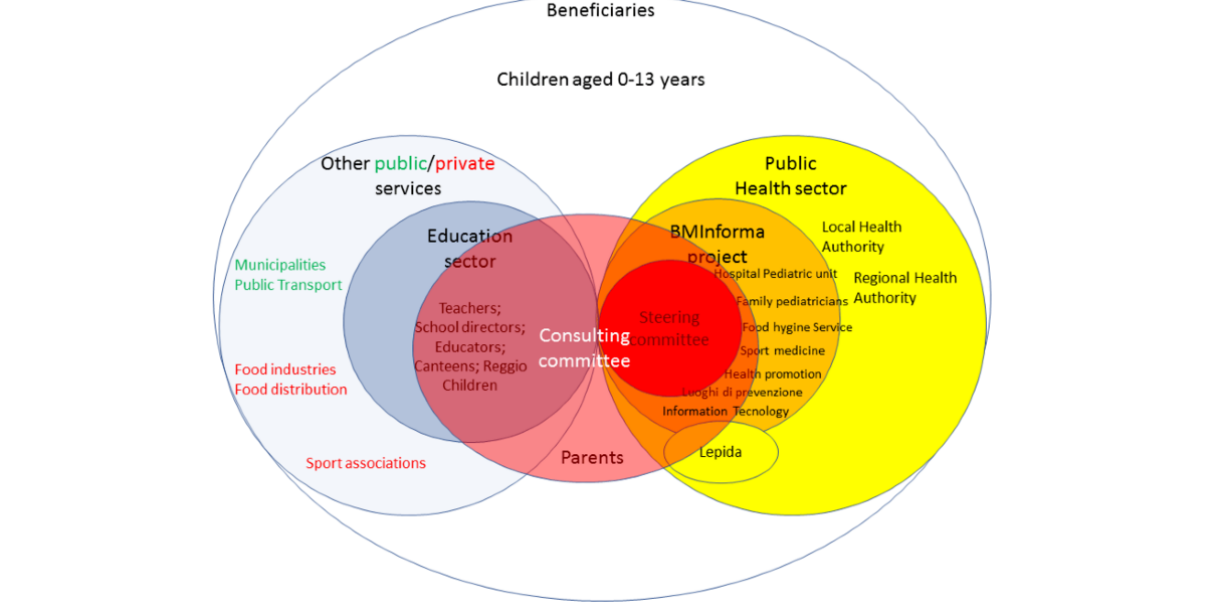
Figure 4. Evolution of the actors and stakeholders and user